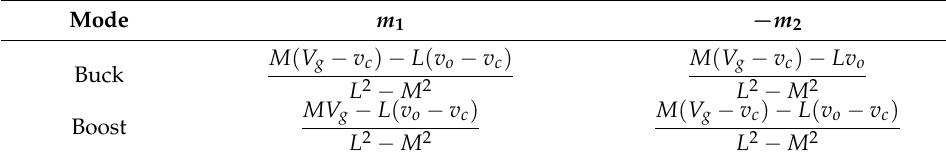
Table 1. Slope of the output current